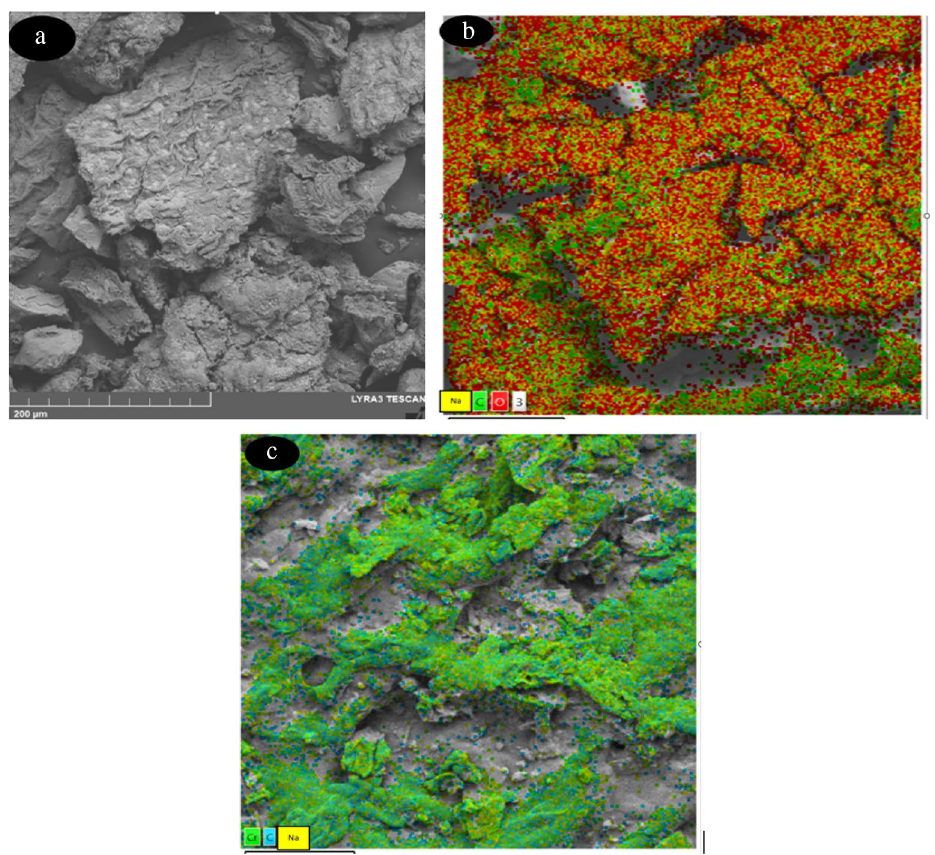
Figure 2. Biomass before ( a ) Cr (VI) adsorption, biomass chemical modifications in ( b ) and shows the distribution of chromium around the whole biomass ( c ).